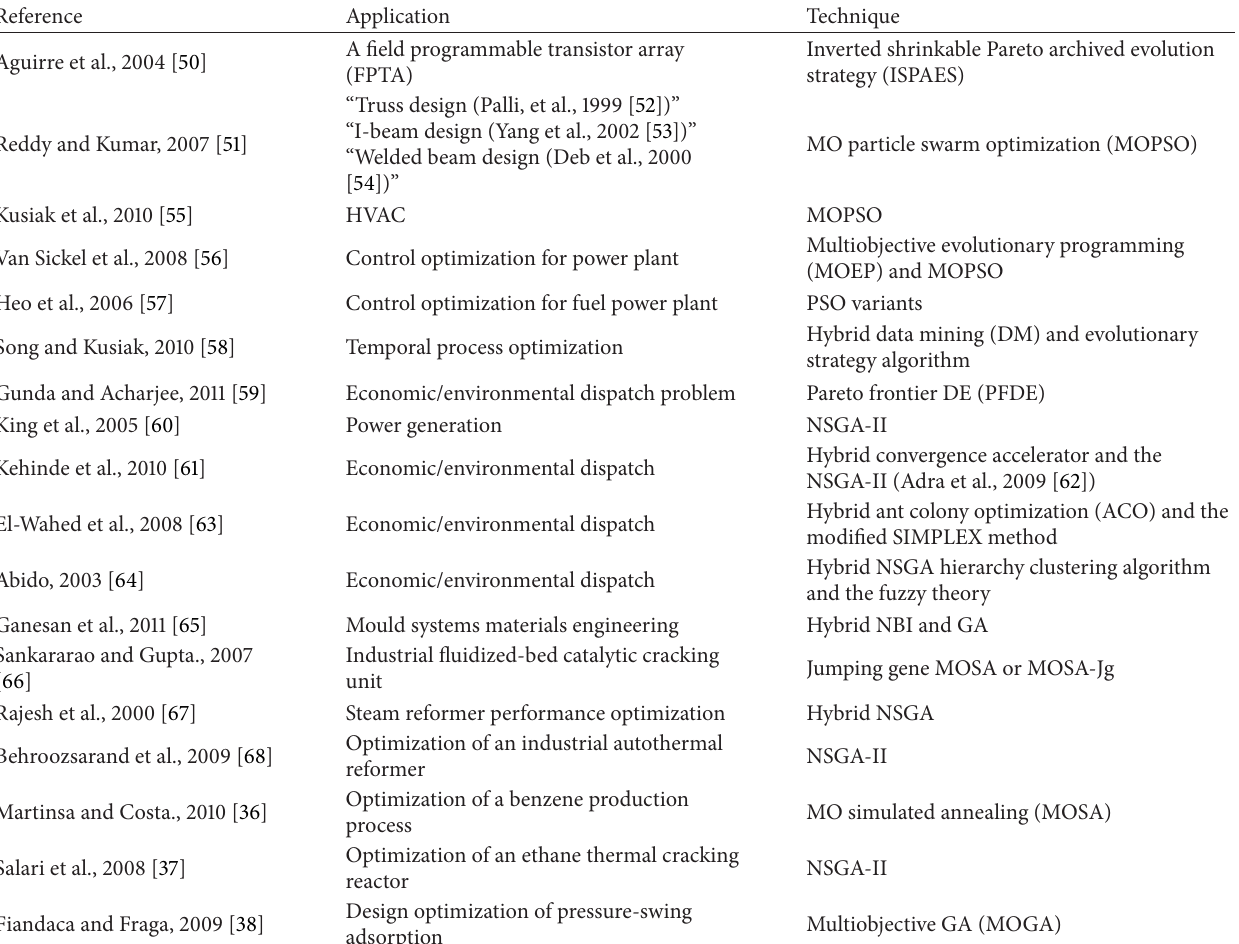
Table 1: Developments of MO optimization in industrial